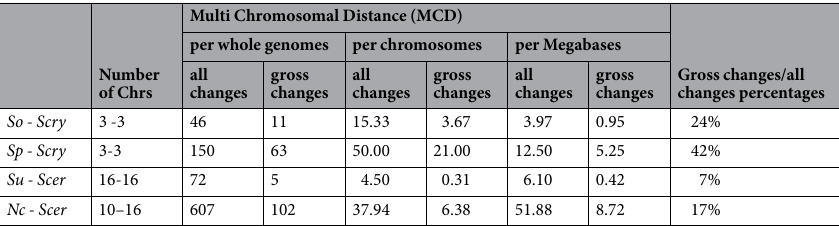
Fig. S4e,f) and performed GRIMM rearrangement analyses with all of the extracted LCBs regardless of their size (Table 2). Based on optimal rearrangement scenarios, the multichromosomal distances (MCDs) (by means of the num- ber of changes that possibly occurred) were proved to be higher in the Saccharomycotina species than in the fission yeasts when we considered all the changes possibly occurred (Table 2). These findings might suggest that fewer chromosomal rearrangements occurred in the genomes of the fission yeasts than in the budding yeast. However, according to an alternative analysis, where we excluded the subtelomeric regions, because these seg- ments are inclined to undergo rearrangements and used only LCBs larger than 20000 nucleotides showed dif- ferent result. That is, considering only the gross changes we could find less chromosomal rearrangements in all pairs of species and our data coincided with the findings of Fischer in the case of S. cerevisiae and S. uvarum 16,17 (Table 2). Later, numbers of the gross changes were compared to the chromosome numbers and sizes of the genomes, and these ratios clearly suggest that more gross rearrangements happened per chromosome (or per megabase) in the fission yeasts genomes (Table 2). That is, individual chromosomes of the fission yeasts bore many more large scale translocations and inversions than chromosomes of the budding yeasts (Table 2). Breakpoint analyses suggested that sites of chromosomal rearrangements could not be ran- dom. In order to obtain information on the sites of chromosomal rearrangements, we identified the chro- mosomal breakpoints between large LCBs ( > 20 000 nts) in the YASS and Mauve alignments. To ensure that breakpoints were correctly revealed, we examined both S. octosporus – S. cryophilus and S. cryophilus – S. octo- sporus alignments. The analyses revealed 19 breakpoints. In the next step, the genes located to the edges of the LCBs were identified and mainly 5S rDNA genes were found (5S rDNAs were associated with 12 breakage sites from the 19) (Supplementary Fig. S5). Thus, we assumed that rearrangements could happen along these repeated sequences. A similar data was found earlier, where inversion endpoints were correlated with repeated sequences 18,19 . In other cases, the rearrangements occurred in large intergenic regions ( > 1000 nts).